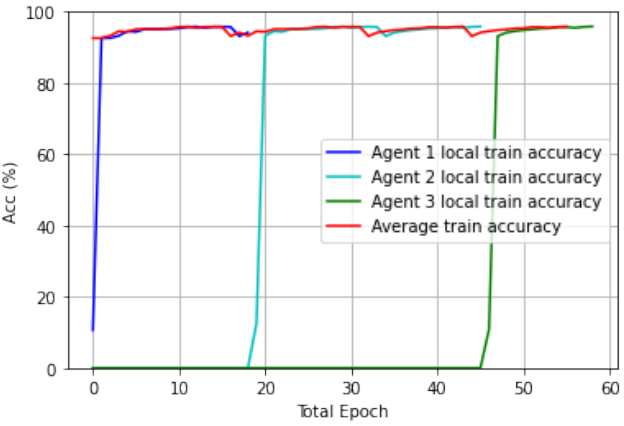
Figure 12. Experiment 4: Effect of adding new agents.